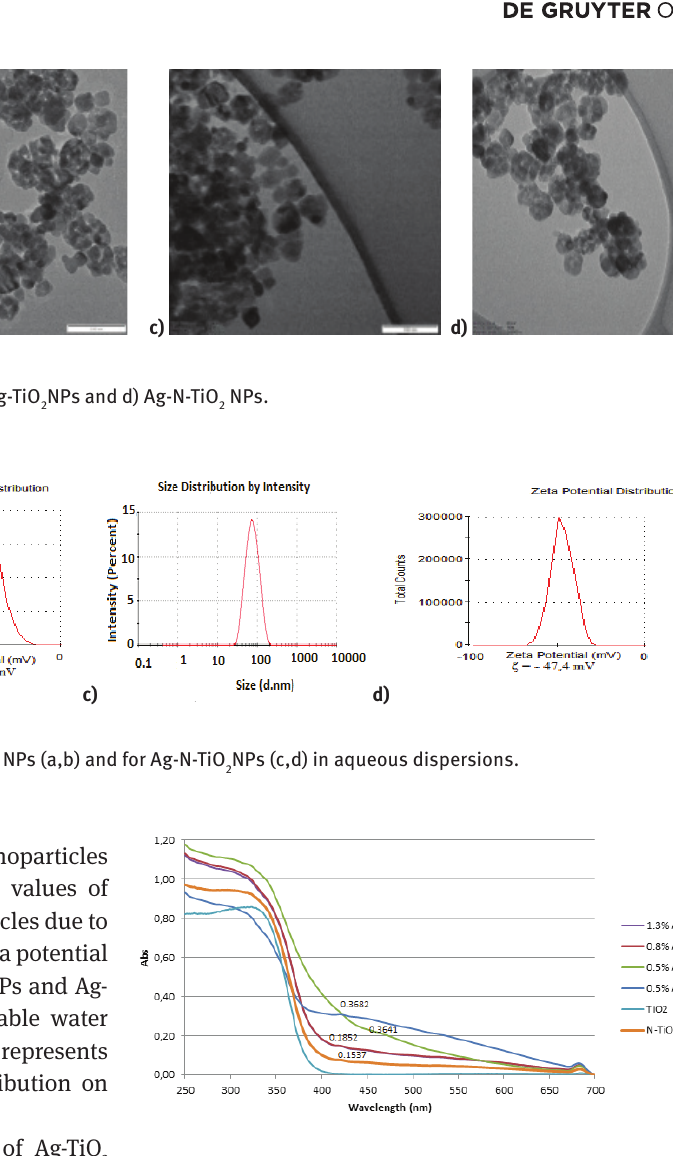
Figure 5: UV-Vis diffuse reflectance spectra of Ag-TiO TiO NPs compared with TiO 2